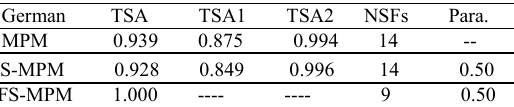
Table 7 TSAs and NSFs for German